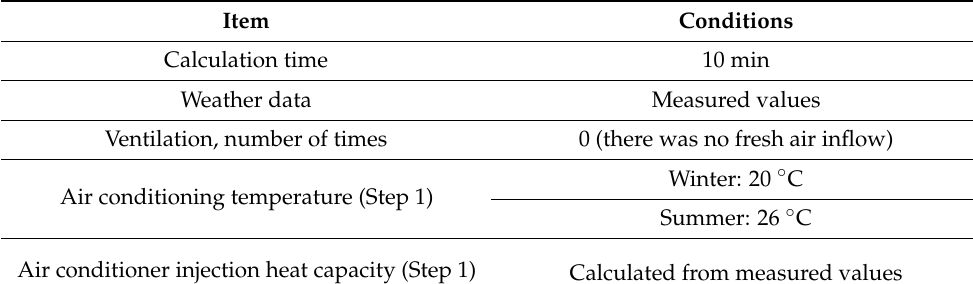
Table 3. THERB analysis